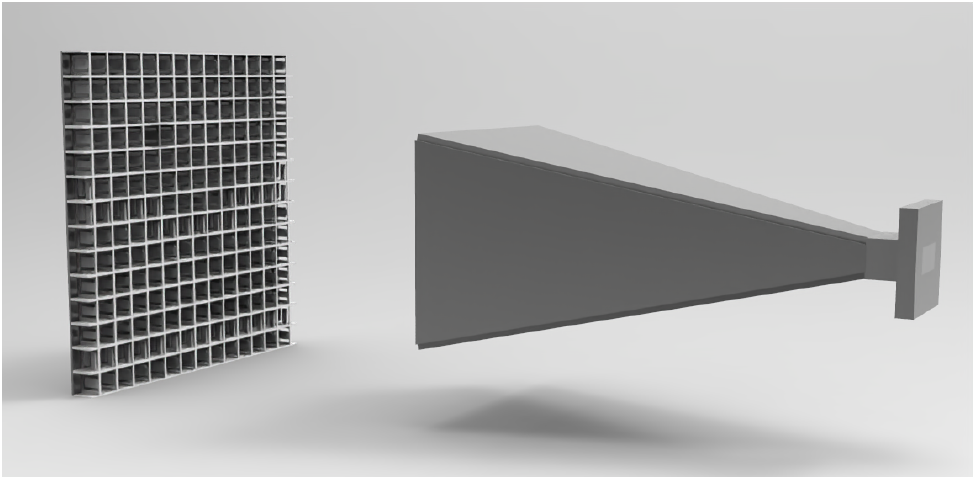
Figure 3. Scenario simulated in CST. The horn feeds the RA from a distance of 15cm. Structure parameters of the cells in the RA: P = 10.53mm, T = 0.5mm, D =